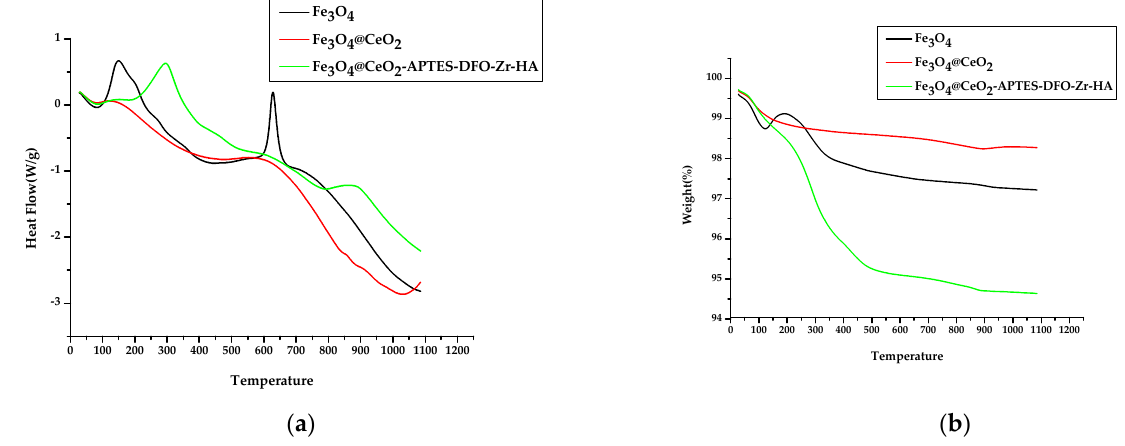
Figure 7. Thermogravimetric Analysis (TGA) measurements for the identification of coated HA of: ( a ) Fe 3 O 4 , Fe 3 O 4 @CeO 2 and Fe 3 O 4 @CeO 2 -APTES-DFO-Zr-HA; Differential Scanning Calorimetry (DSC) measurements to measure the change in physical properties of substances of ( b ) Fe 3 O 4 , Fe 3 O 4 @CeO 2 and Fe 3 O 4 @CeO 2 -APTES-DFO-Zr-HA at different temperatures.